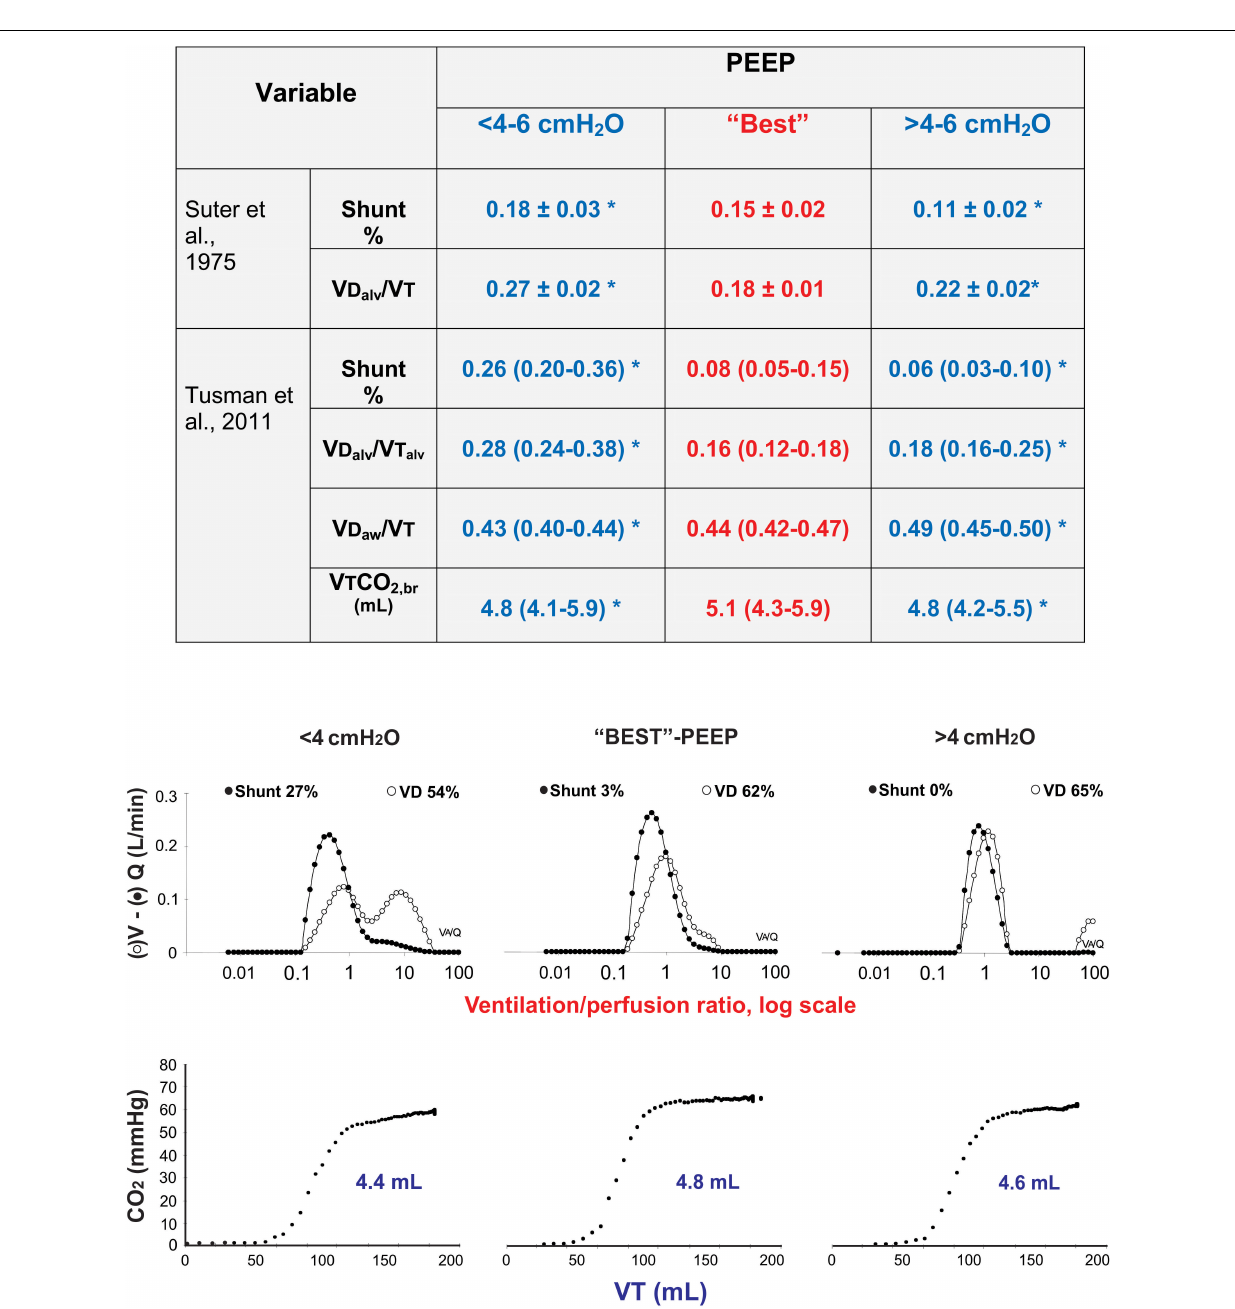
FIGURE 3 | Dead space at optimum PEEP. Comparison of the data obtained by Suter et al. (1975) using Enghoff’s approach with our more recent data using VCap using Bohr’s approach and multiple inert gas elimination technique (MIGET) (Tusman et al., 2011b). Physiological dead space measured by MIGET and VCap airway dead space increase proportional to PEEP, whereas shunt decreases with PEEP. An individualized level of PEEP (“Best” PEEP) corresponding to maximal respiratory system compliance, resulted in the lowest alveolar dead space and the highest elimination of CO 2 measured by VCap. PEEP above and below this optimum value results in an increased alveolar dead space and decreased the elimination of CO 2 per breath (VTCO 2 , br ). (*) p < 0.05 compared to best